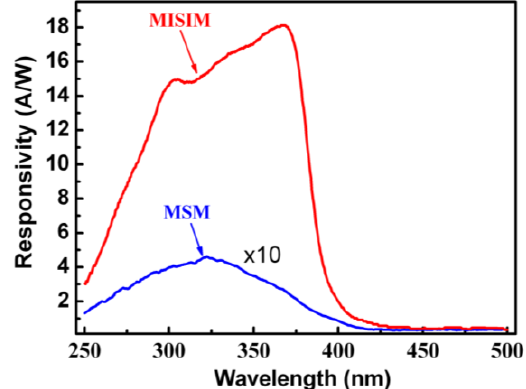
Figure 3. Photoresponse of the MISIM and MSM structured ZnO photodetectors at 24 V bias. Note that the responsivity of the MSM photodetector has been magnified by 10